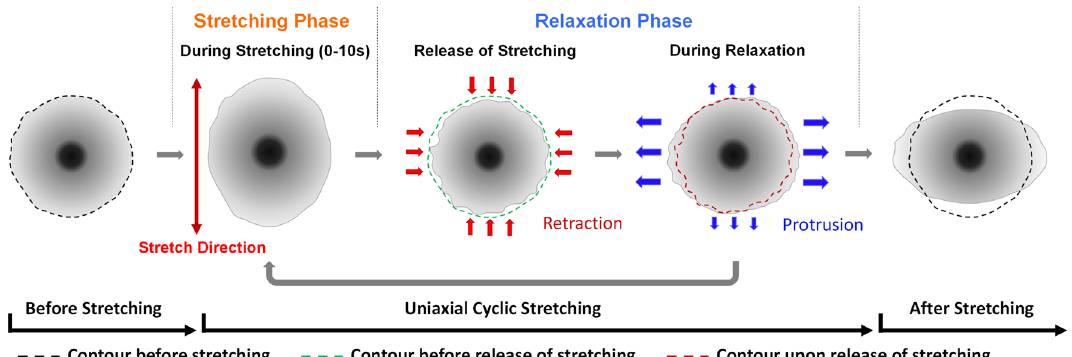
Figure 7. Summary of spatially and temporally dependent protrusion/retraction activities that lead to cell reorientation in response to uniaxial cyclic stretching. Cells (greyscale circle) retract immediately upon the release of stretching (red arrows), followed by progressive extension during the relaxation phase (blue arrows). The effects accumulate upon prolonged cyclic stretching, which leads to the change in cell shape and